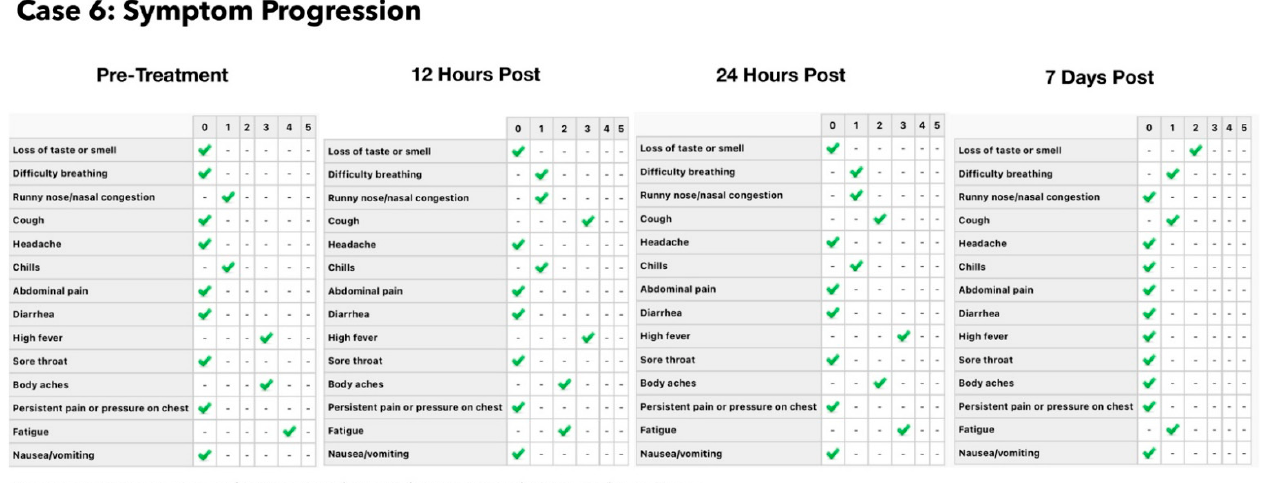
Figure 14. Shows symptom progression of subject six pre-treatment, 12 h, 24 h and 72 h post-treat- ment based on symptom scale ranging from